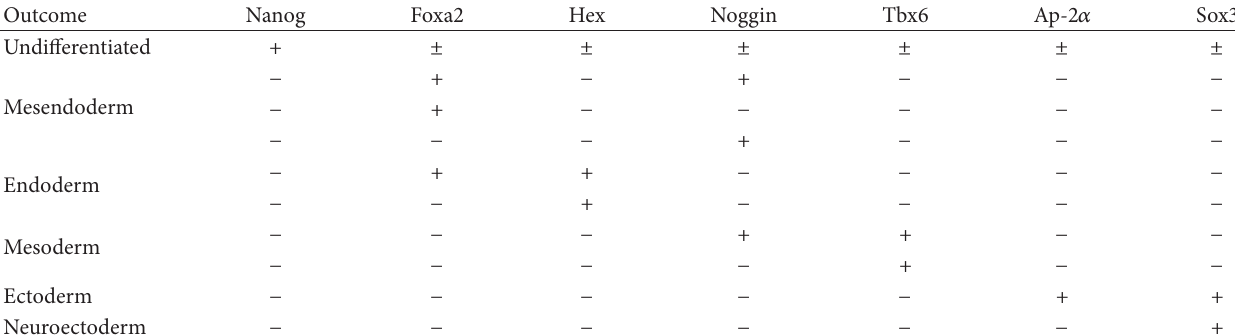
Table 3: Cell fate definitions (individually conjugated antibodies used together).